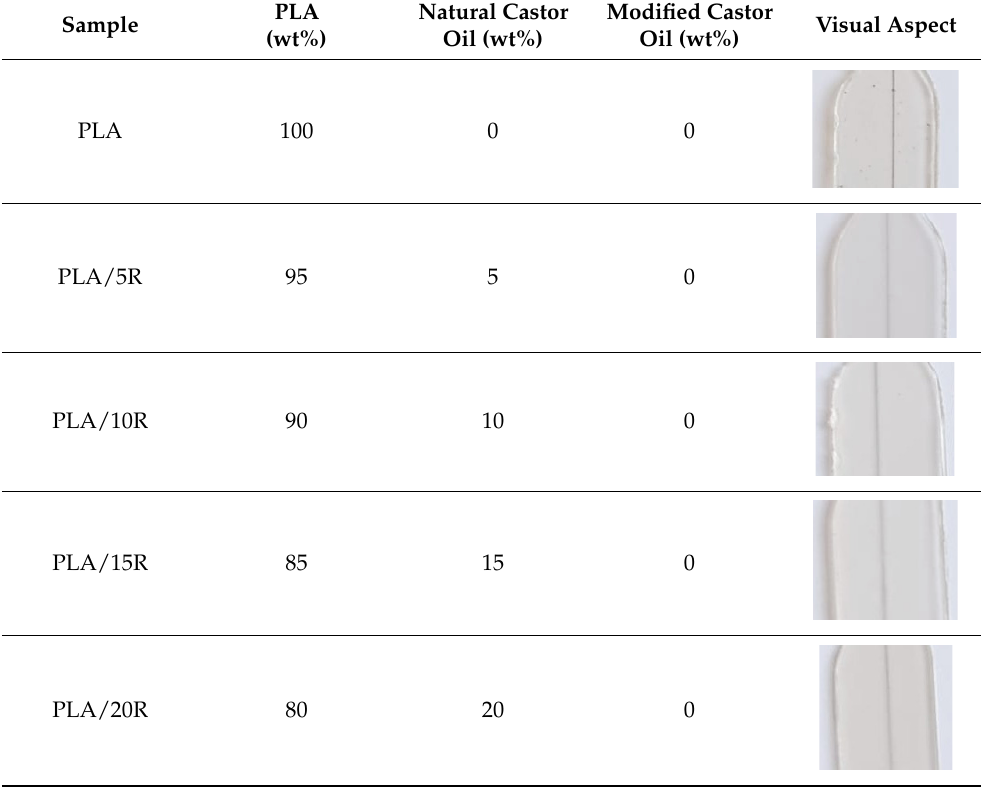
Table 1. Labeling, composition and visual aspects of neat PLA and PLA-based materials containing unmodified and modified castor oil.